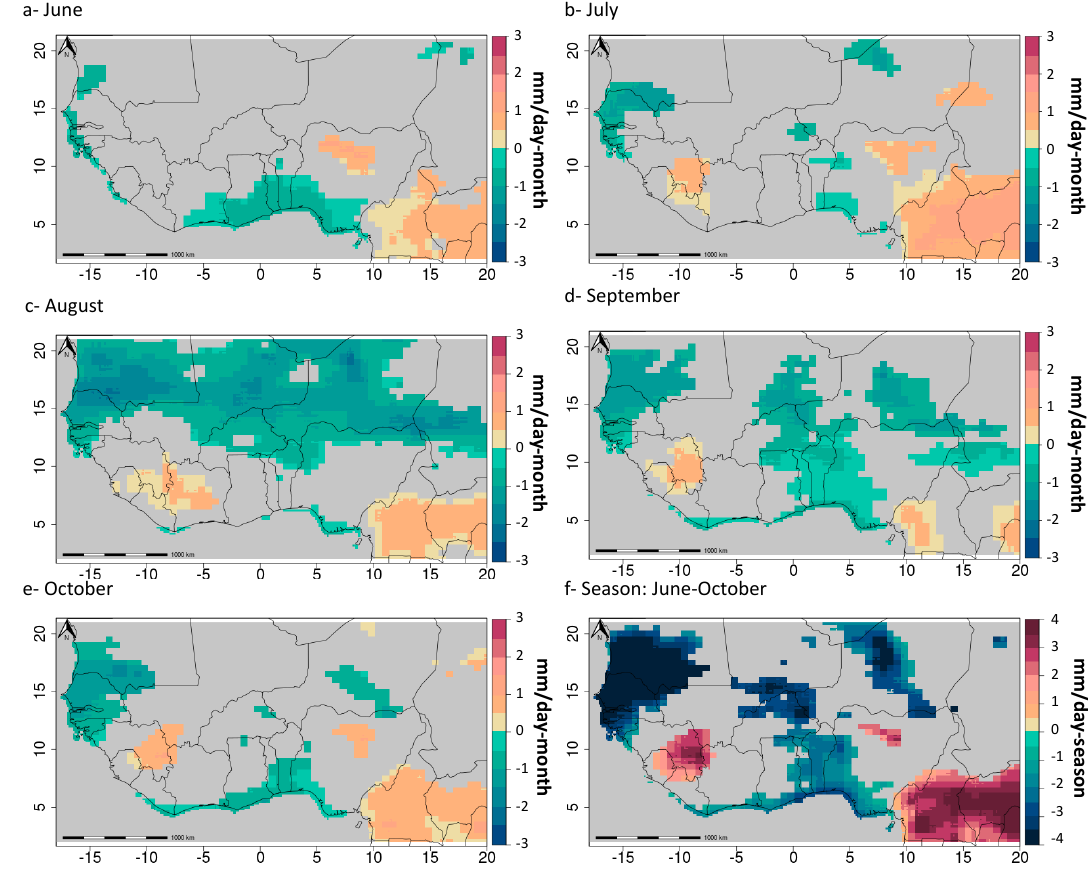
Figure 4. ET 0 regressions for the months of June ( a ), July ( b ), August ( c ), September ( d ), October ( e ), and full season ( f ) calculated from 1981 to 2016. The units in ( a ) through ( e ) have been capped to − 3 to 3 mm day − 1 month − 1 , while the units in f have been capped from − 4 to 4 mm day − 1 season − 1 . Any insignificant slope ( p > 0.05) has been masked out in